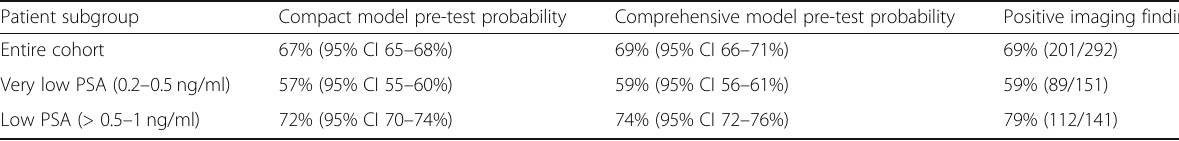
Table 2 Subgroup analysis of pre-test probability and actual positive findings in 68 Ga-PSMA-11-ligand PET Patient